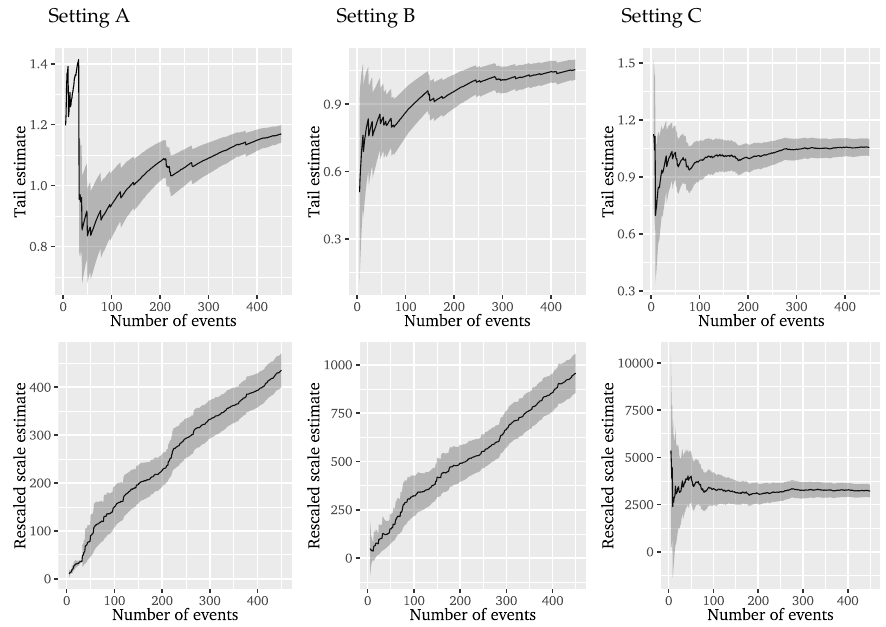
Figure 17. Mittag–Leffler parameter stability plots for the inter-event times of the simulated settings A, B and